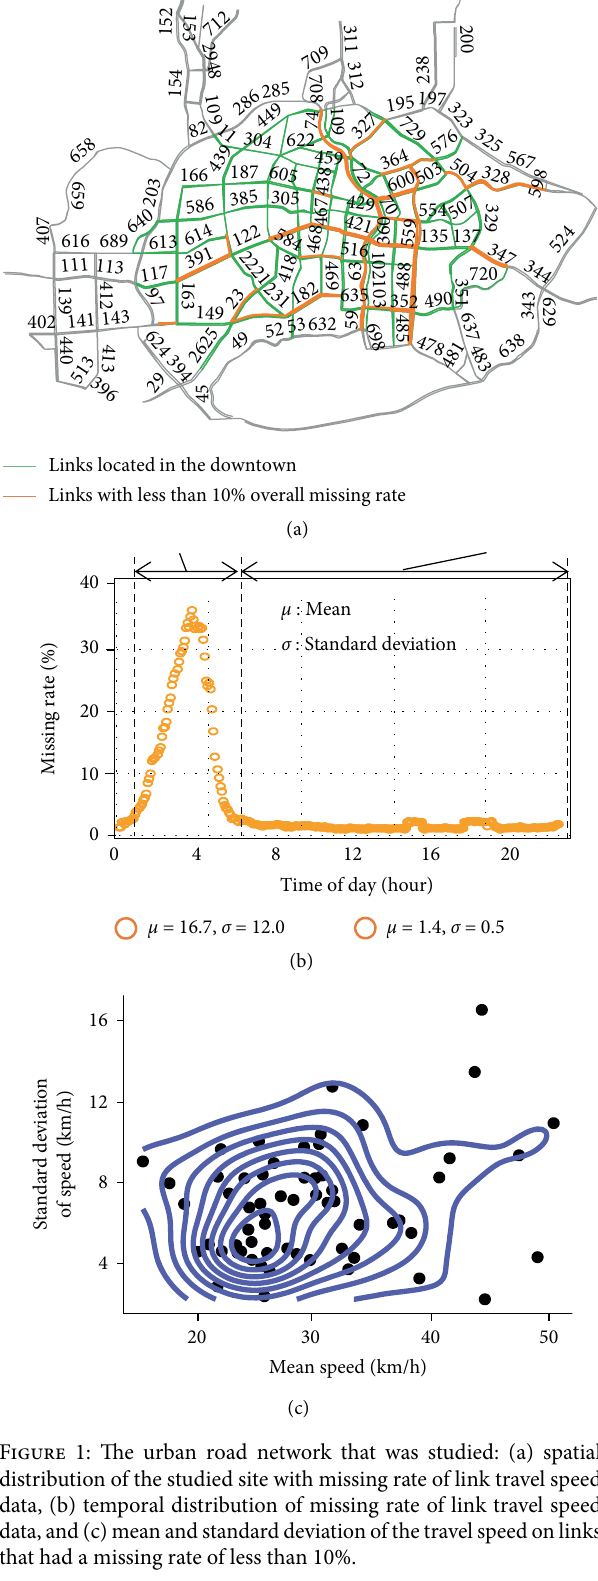
Figure 1: The urban road network that was studied: (a) spatial distribution of the studied site with missing rate of link travel speed data, (b) temporal distribution of missing rate of link travel speed data, and (c) mean and standard deviation of the travel speed on links that had a missing rate of less than located in the downtown to ensure the reliability of DSRC data with sufficient traffic volume to minimize the missing rate of the data, and those links are highlighted in green lines